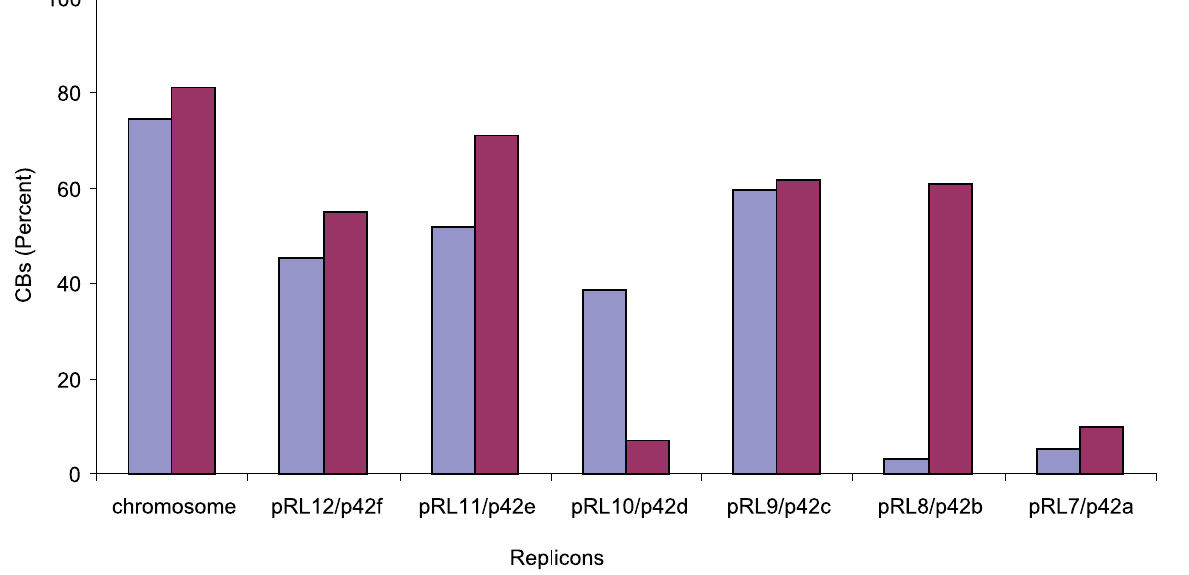
Figure 3. The proportion of synteny in the R.etli genome as compared to the R.leguminosarum genome. - The proportion of synteny is expressed as the percentage of the total DNA in CBs (Y axis) considering the total length of the pairs of replicons (X axis). Blue color R. etli CFN42; magenta, R. leguminosarum 3841.